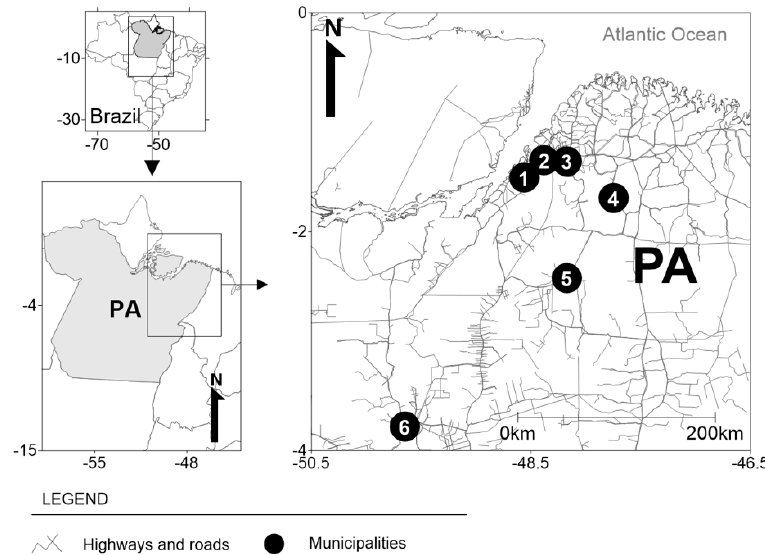
Figure 1. Geographic location of municipalities in the Brazilian state of Pará (PA) where dentists worked and provided information for this study. Cities: (1) Belém, (2) Ananindeua, (3) Benevides, (4) São Domingos do Capim, (5) Tomé Açu, and (6) Tucuruí.